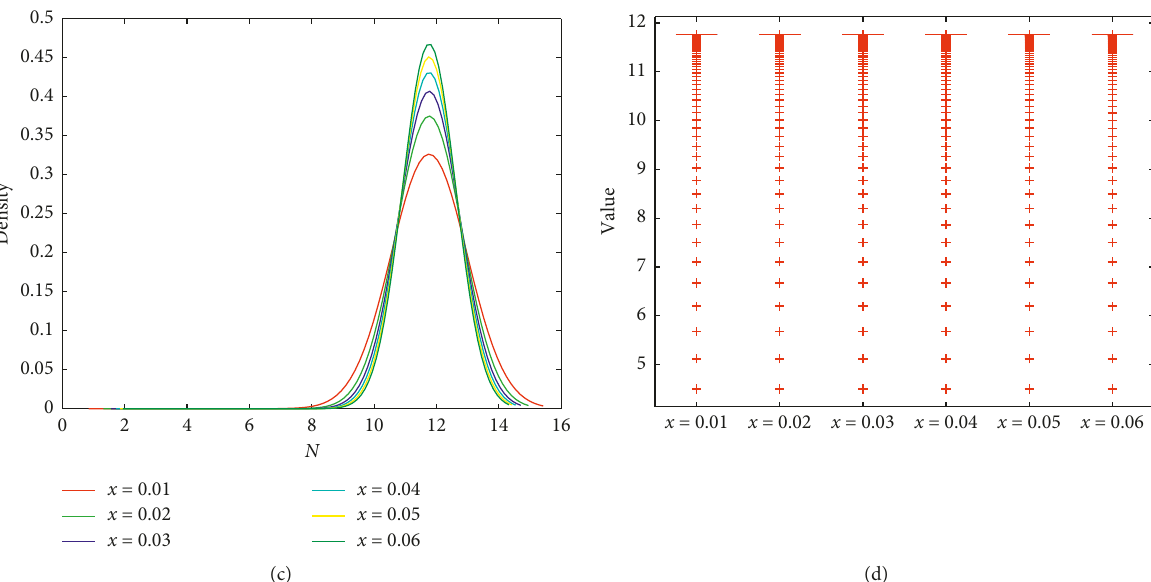
Figure 7: The effect of cell size on the existence of stationary distribution for model (3) with different cell size x � 0 . 01 , 0 . 02 , 0 . 03 , 0 . 04 , 0 . 05 , 0 . 06. (a) and (c) are the probability density function of phytoplankton and nutrient in model (3), respectively. (b) and (d) are the boxplot of the solution for phytoplankton and nutrient in model (3) with the corresponding cell size,